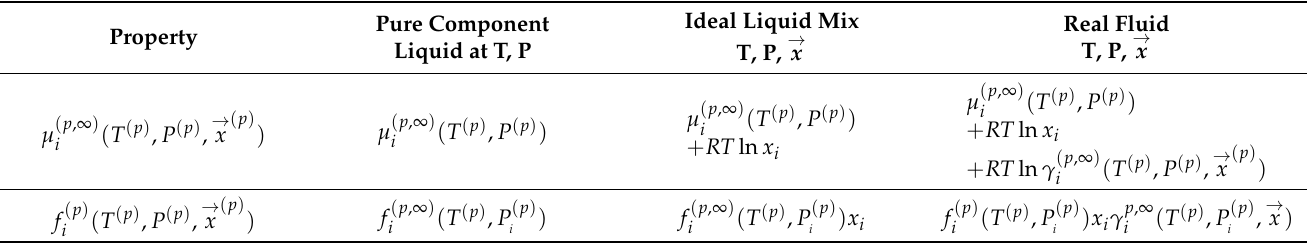
Table 3. Asymmetric excess integration scheme for chemical potential and fugacity. Pure Component Property Liquid at T, P